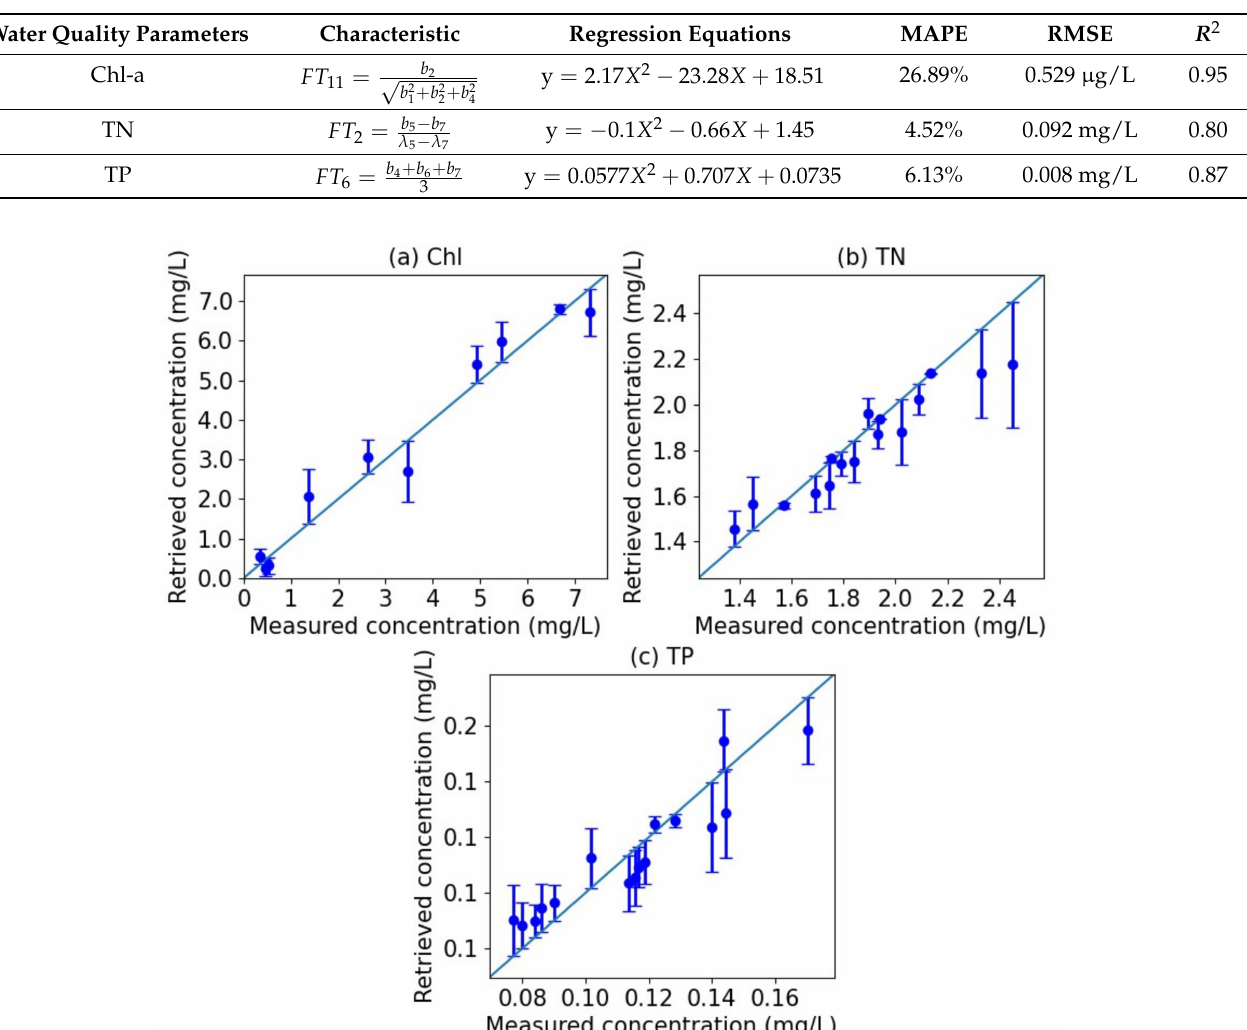
Table 1. Regression analysis of Chl-a, TN, and TP.